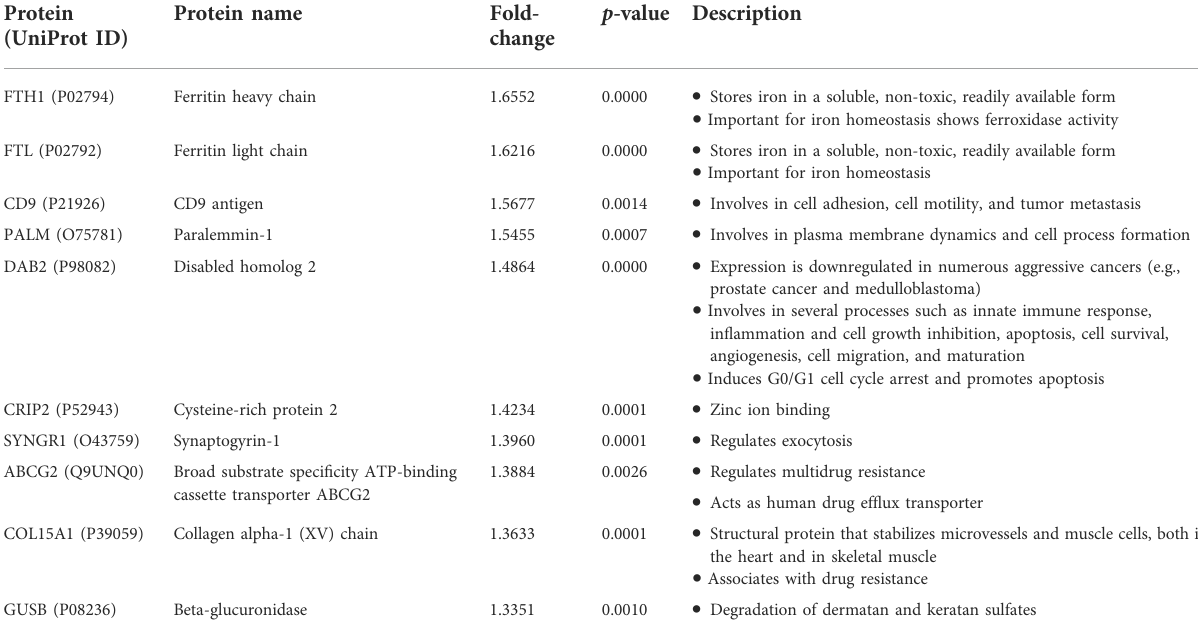
TABLE 1 Top-10 upregulated proteins identi fi ed in the ZIP8-KO cells.